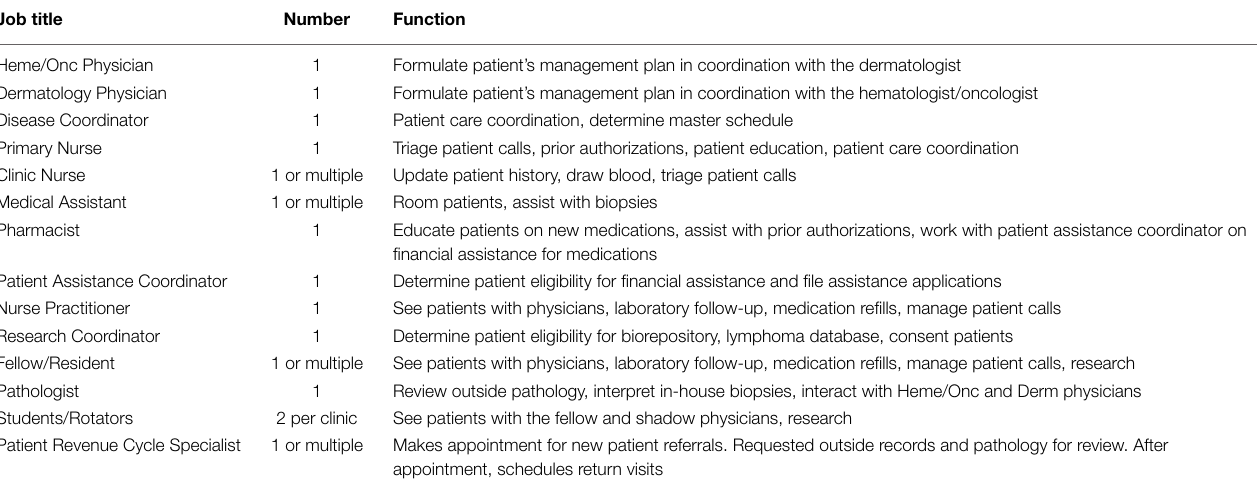
TABLE 1 | Essential elements of a multimodality cutaneous lymphoma clinic . Job title